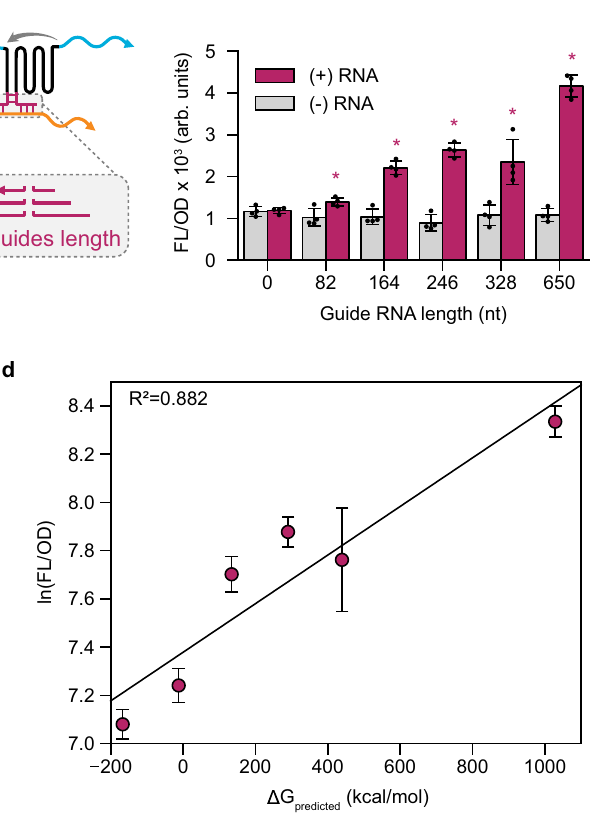
( a , b ) and points in ( d ) represent meanvalues and error bars represent s.d. of n =4 biologicalreplicates.Forpanel( a ),signi fi cancewasdeterminedusingatwo-tailedt- test (alpha = 0.05), which resulted in p -values of 1.95e − 5, 5.4e − 8, 1.33e − 3, 4.5e − 3, 1.97e − 4, and 0.25 for (+) RNA samples RFP1, RFP2, CD1, CD2, TA1, TA2 relative to their ( − ) RNA counterparts, respectively. The same test was used in panel ( b ), with p -values of 0.76, 0.019, 7.56e − 5, 9.09e − 6, 5.1e − 3, and 9.7e − 7 for (+) RNA samples with guide length 0, 82, 164, 246, 328, and 650 relative to their ( − ) RNA counter- parts, respectively. Statistically signi fi cant differences ( p <0.05) are indicated by asterisks above bars. Source data for ( a ), ( b ), and ( d ) are provided as a Source Data fi